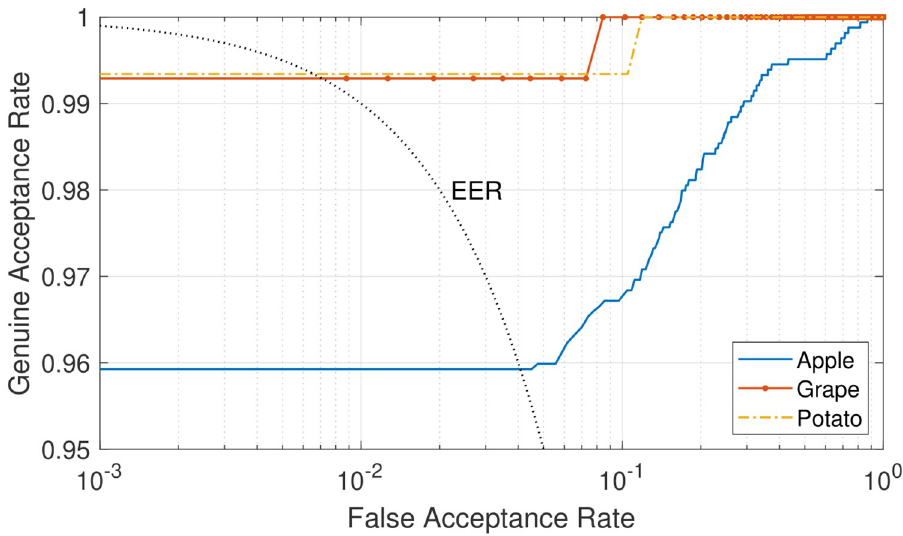
Fig 9. System performance analysis through receiver operating characteristic (ROC) curves obtained using the proposed approach for healthy and diseased classification over the apple, grape, and potato culture datasets.